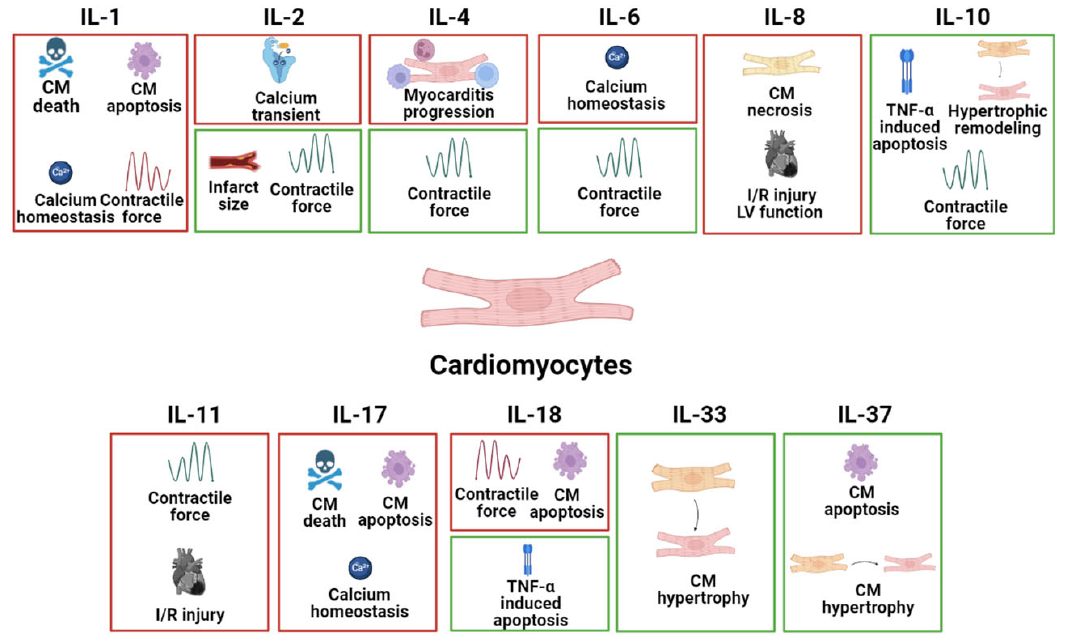
Figure 1. The specific pathophysiological effects of different interleukins on CMs in common heart disease. The box in red represents the deleterious role, and the box in green represents the protective role.